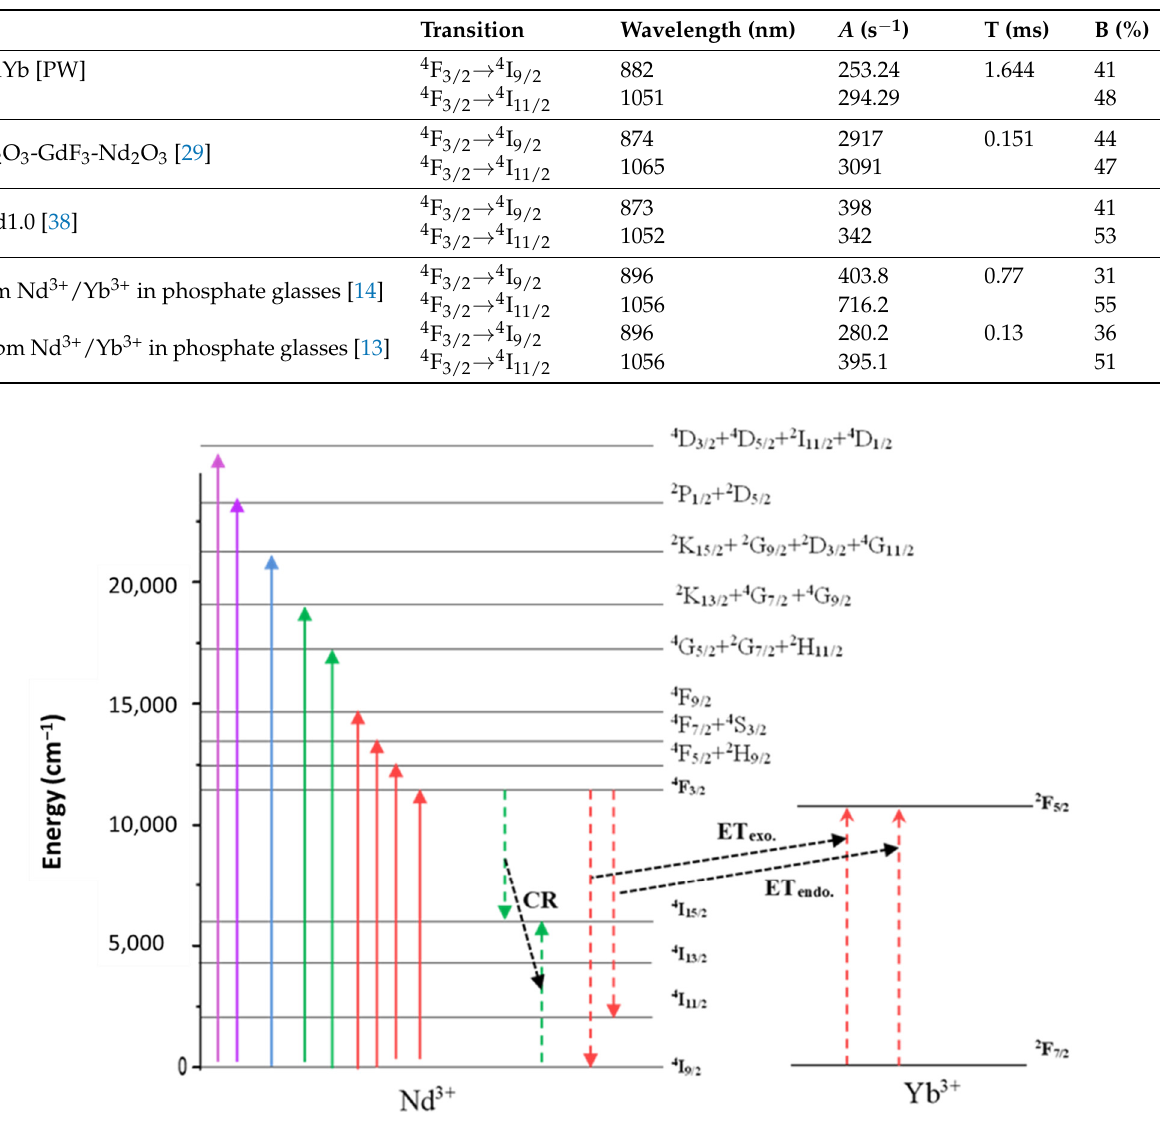
Figure 4. Energy level diagrams of Nd 3+ and Yb 3+ ions.